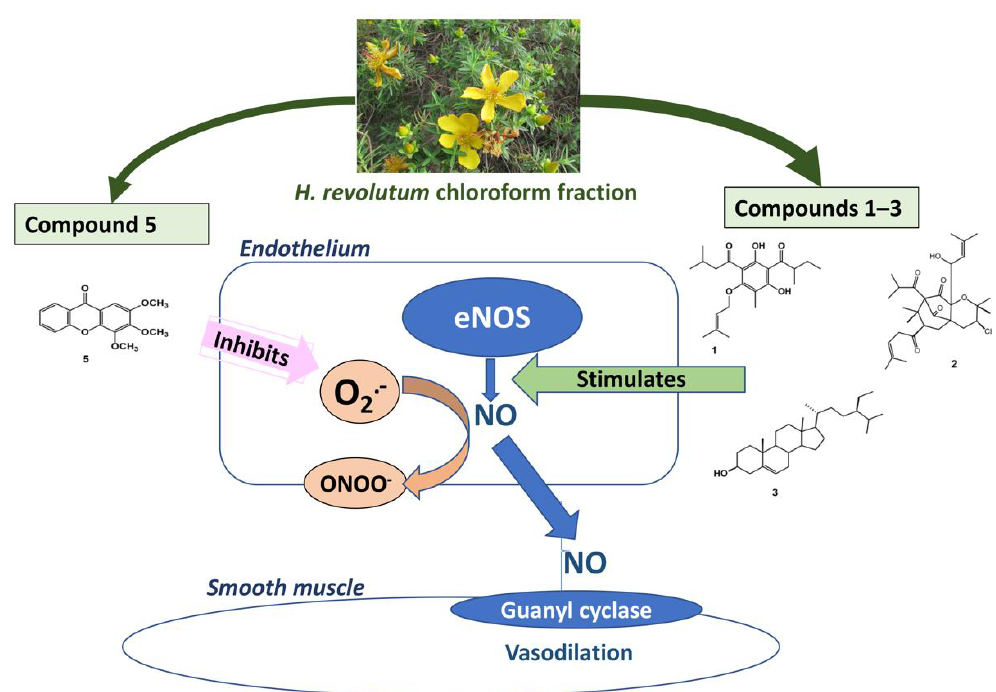
Figure 9. Diagrammatic sketch summarizing the proposed pharmacological mechanism.